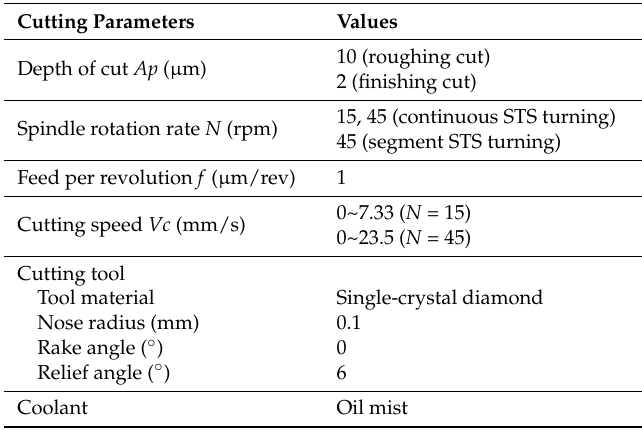
Table 1. Cutting conditions for a hexagonal microlens array on aluminum alloy.